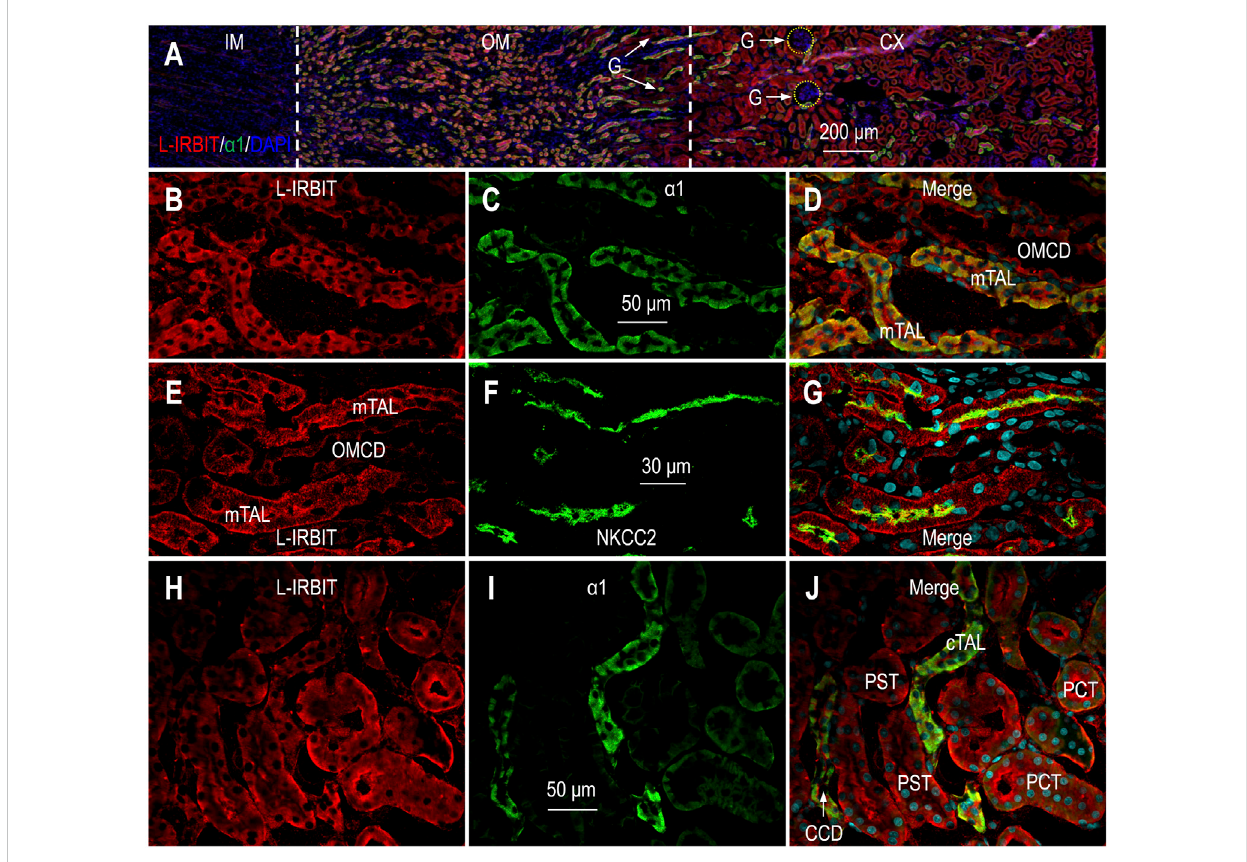
FIGURE 3 Indirect immuno fl uorescence of L-IRBIT in rat kidney. (A) Merged overview of the double-staining of L-IRBIT (red) and α 1 (green). The original unmerged images of L-IRBIT and α 1 were shown in Supplementary Figure S4. (B – D) Localization of L-IRBIT and α 1 of Na + -K + -ATPase in outer medulla. (E – G) LocalizationofL-IRBITandNKCC2inoutermedulla. (H – J) LocalizationofL-IRBIT(red)and α 1(green)incortex.CX,cortex;IM,innermedulla;OM, outer medulla; mTAL, medullary thick ascending limb; OMCD, outer medullary collecting duct. Blue indicates the nuclei counter-stained by